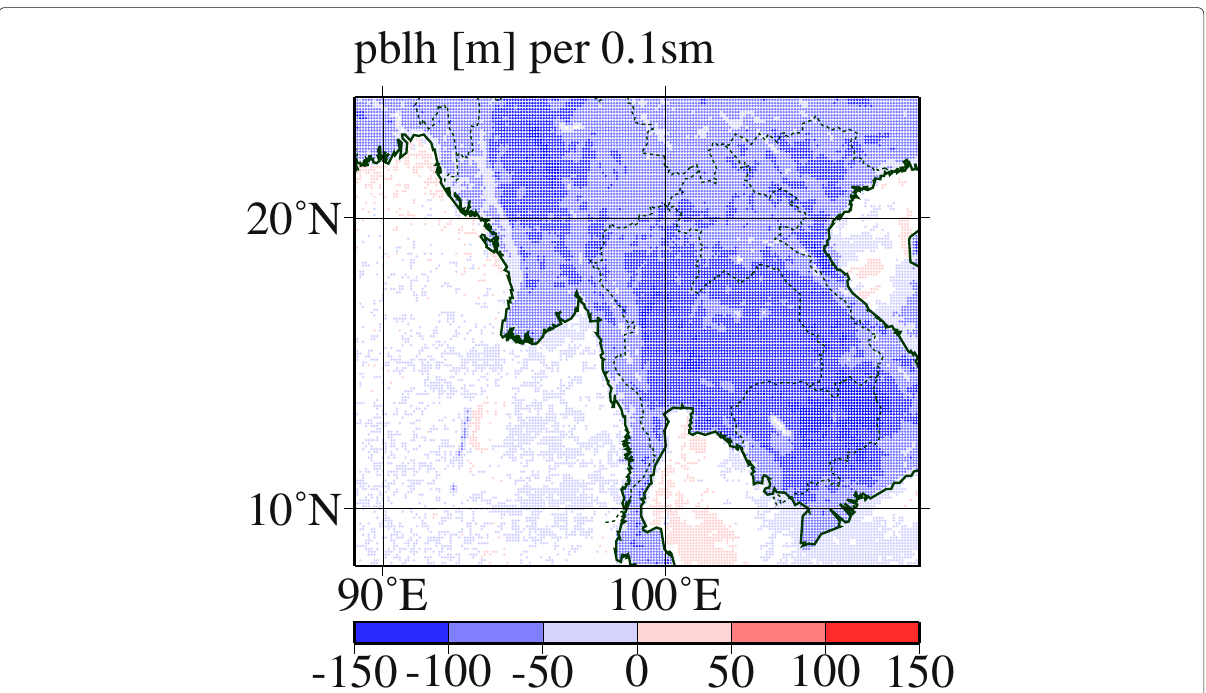
Fig. 9 Same as Fig. 3 but for planetary boundary layer height. The units are m per 0.1 increase in soil moisture hydrometeors and water vapor. There may be a positive feedback mechanism between active deep convection and the increase in planetary boundary layer height.